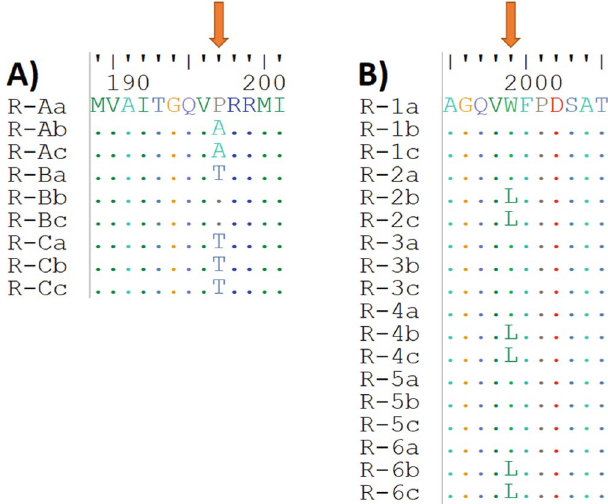
Figure 1. The alignment of blackgrass ALS ( A ) and ACCase ( B ) amino acid sequence fragments derived from the plants belonging to the R biotype. The red arrow indicates the mutations known to confer herbicide resistance to ALS or ACCase inhibitors. ( A ) The uppercase letters (A, B, or C) in sequence names represent DNA templates used in PCR—consisting of pooled equal amounts of DNA isolated from two plants. Amino acid numbering refers to the blackgrass ALS sequence ( B ). The numbers in the sequence names represent the plant number. The amino acid numbering refers to blackgrass ACCase sequence, a–c—clone name.